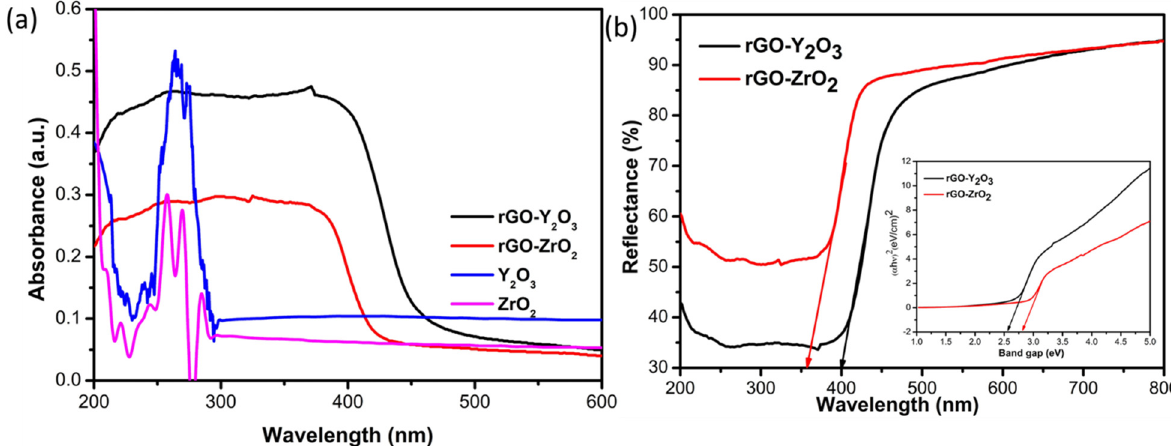
Figure 4. ( a )UV-Visible spectra of rGO-Y 2 O 3, rGO-ZrO 2 , Y 2 O 3 and ZrO 2 ( b ) UV-DRS spectra of rGO- Y 2 O 3, rGO-ZrO 2 Figure 4. Inset Tauc plot of rGO-Y 2 O 3, rGO-ZrO 2 .